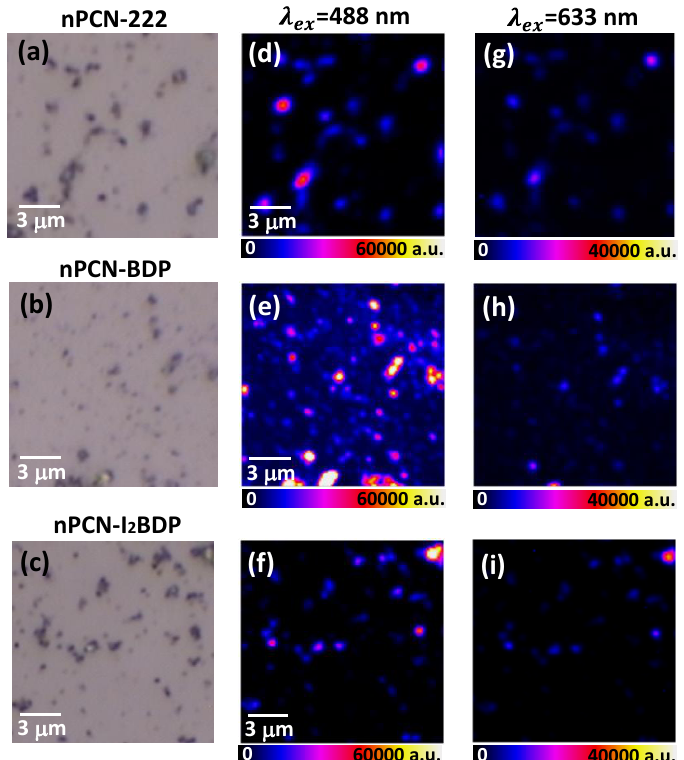
Figure 5. Microscopy images of ( a ) nPCN-222, ( b ) nPCN-BDP, and ( c ) nPCN-I 2 BDP. Fluorescence images of porphyrin ligand of ( d ) nPCN-222, ( e ) nPCN-BDP, and ( f ) nPCN-I 2 BDP after 488 nm excitation. Fluorescence images of ( g ) nPCN-222, ( h ) nPCN-BDP, and ( i ) nPCN-I 2 BDP after 633 nm excitation. All images were obtained by integrating 630–750 nm emission range.